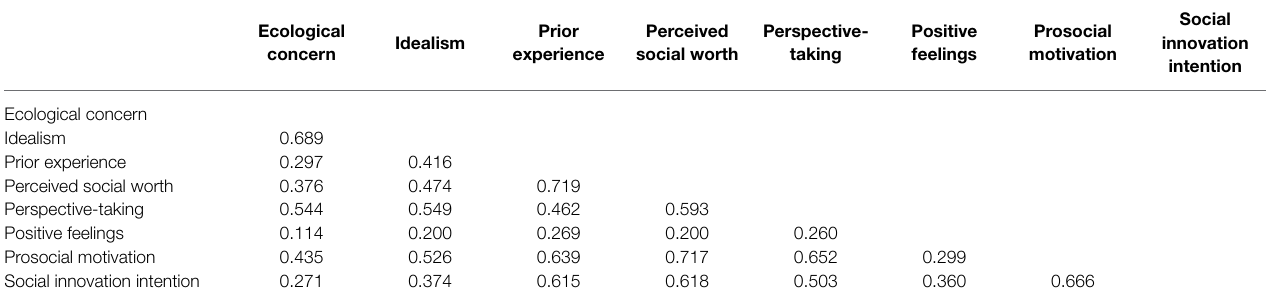
TABLE 3 | Discriminative validity (Heterotrait-Monotrait ratio) of research model.